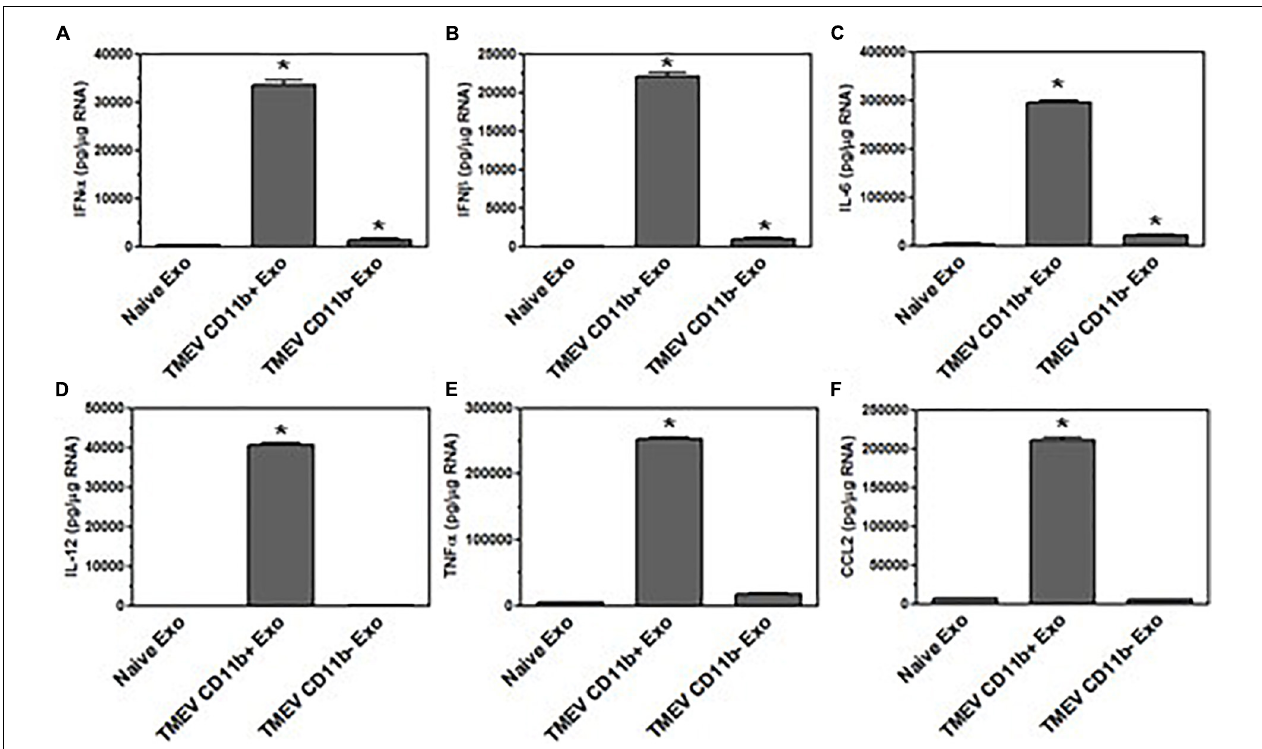
FIGURE 8 | Exosomes secreted by microglia during TMEV infection in mice activate bystander microglia. Exosomes were isolated from the brains of TMEV-infected mice at 2 days post-infection (three mice per group). The exosomes from the brains of TMEV-infected mice and naïve mice were sorted for CD11b + and CD11b - exosomes which were then placed on unstimulated microglia. After 24 h, the microglia were lysed, RNA isolated, converted to cDNA, and used in real time PCR with primers for IFN α (A) , IFN β (B) , IL-6 (C) , IL-12 (D) , TNF α (E) , and CCL2 (F) . Significant difference was determined by the one way ANOVA and Bonferroni’s multiple comparison test (* p < 0.001) based on microglia that were incubated with exosomes secreted by microglia in naive mice. These are representative graphs from one experiment of four independent repeated